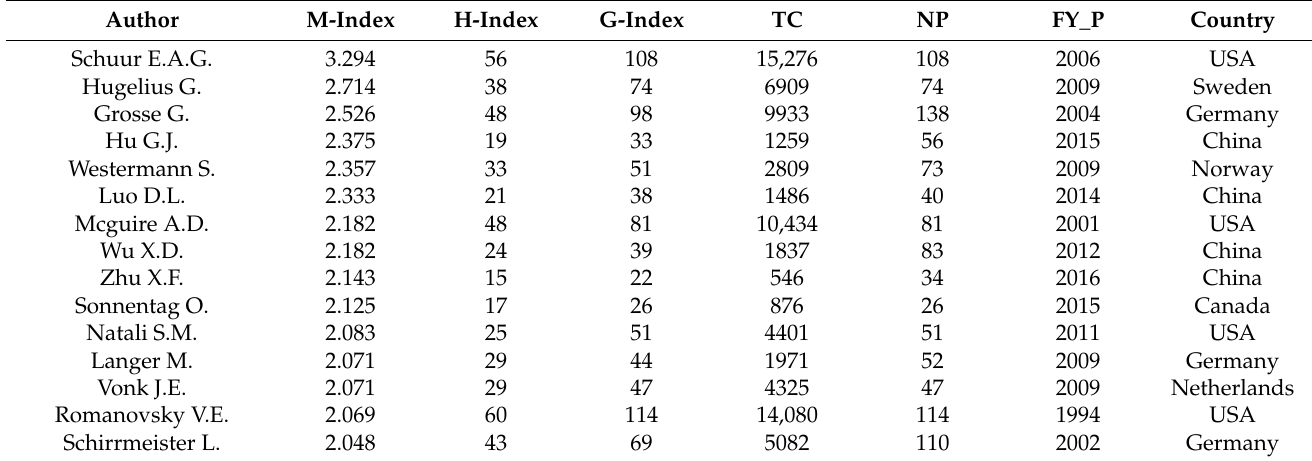
Table 5. The top 15 core authors on permafrost research ranked by M-index.